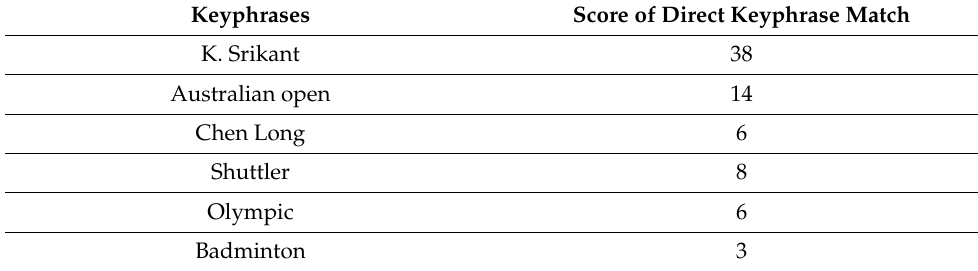
Table 1. Keyphrase